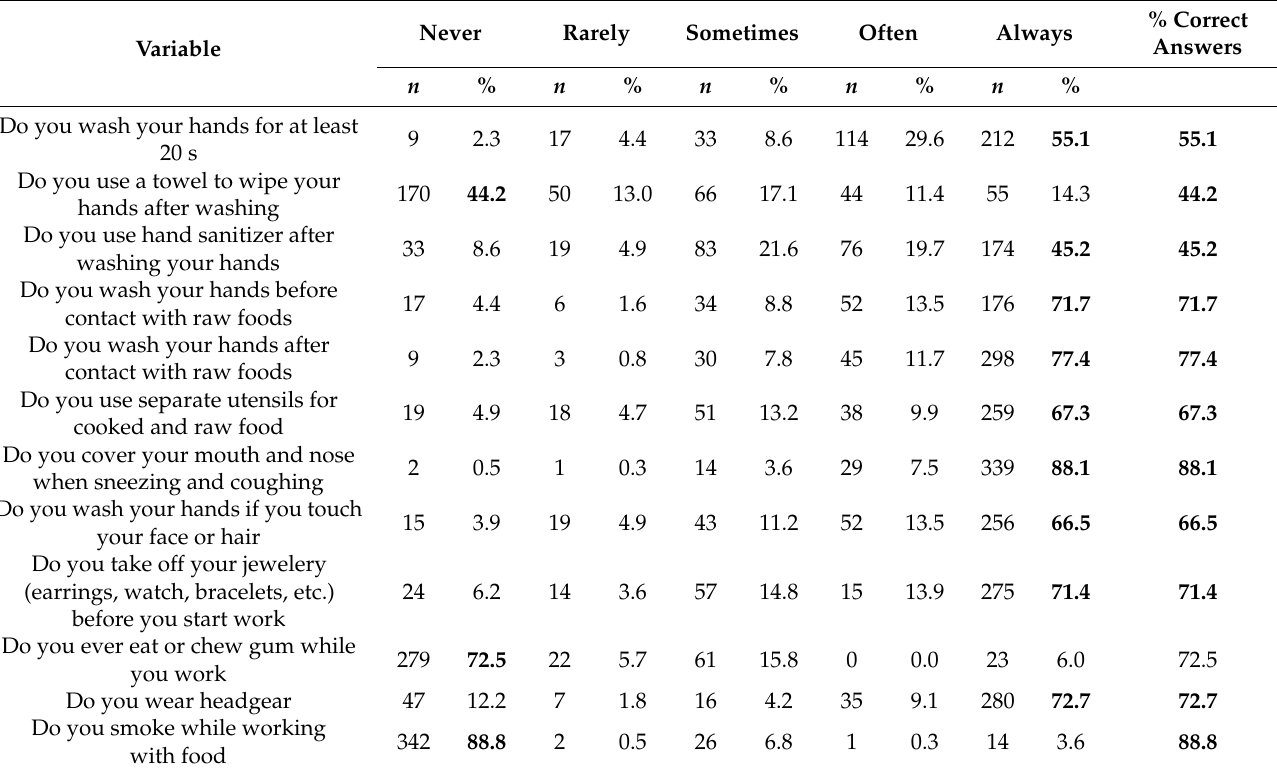
Table 2. Behaviour of employees before the training ( n =